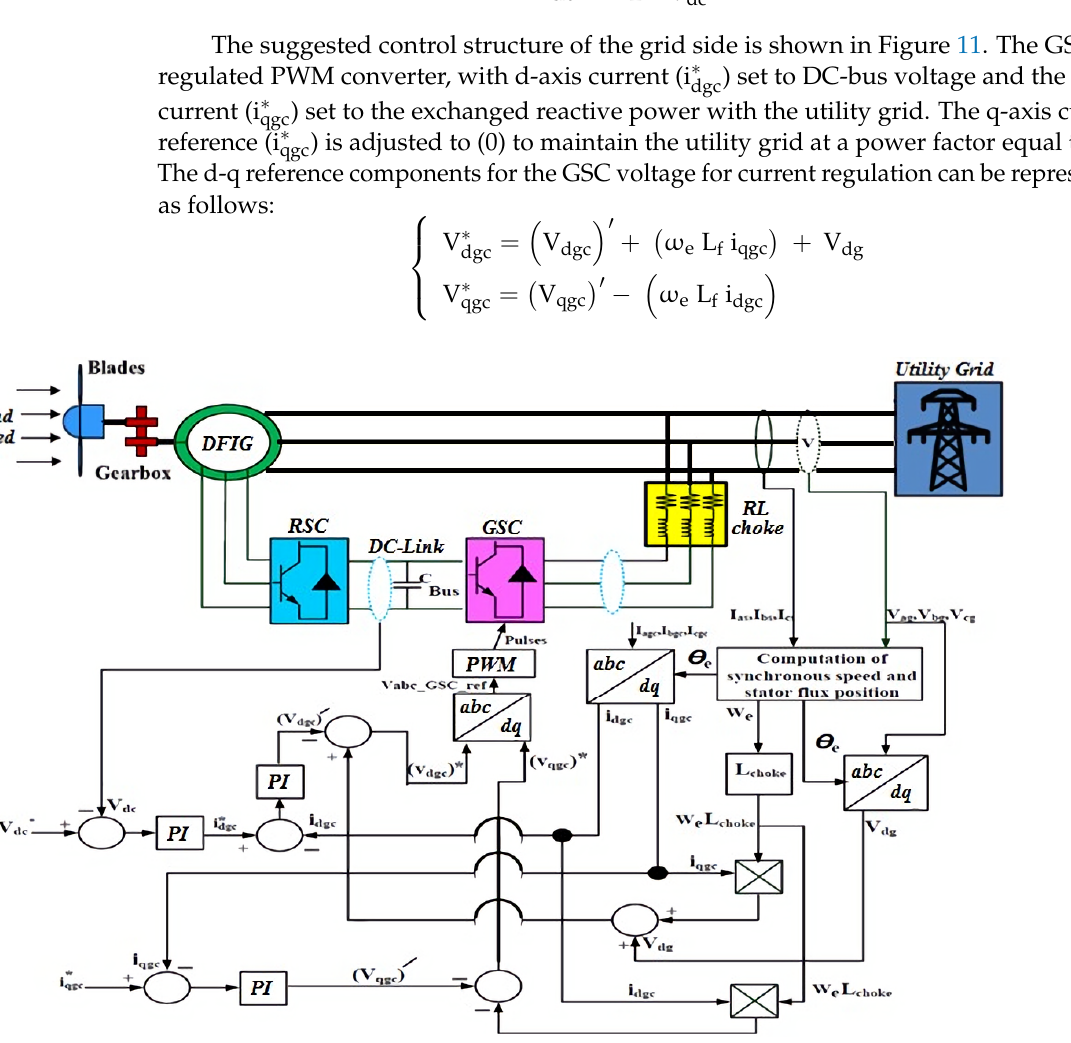
Figure 11. Schematic diagram control for GSC.